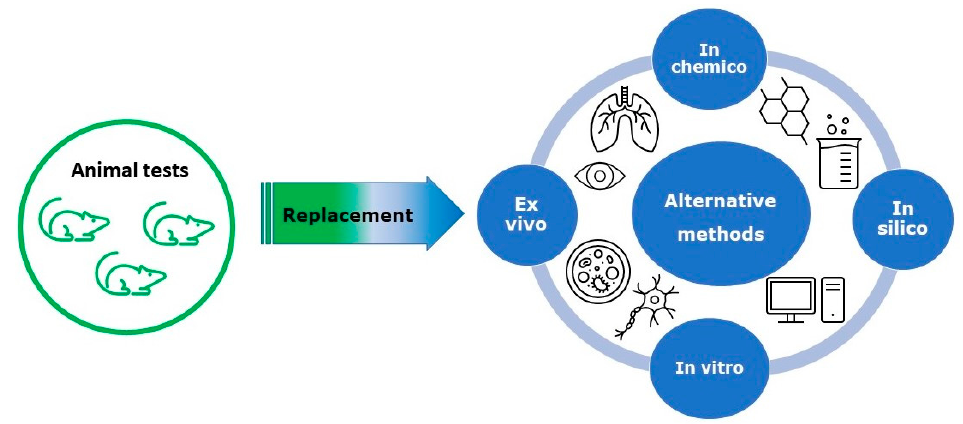
Figure 1. Basic systems used as partial or full replacement of animals.